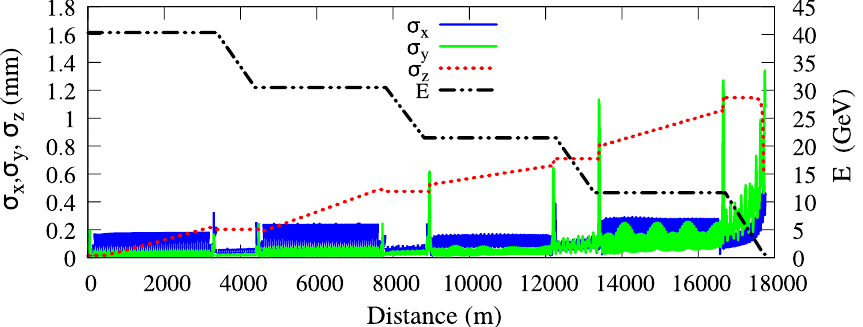
FIG. 11. Beam energy and beta functions for the deceleration of the spent beam, after lasing at 0.5 Å, over two complete LHeC turns starting from 40